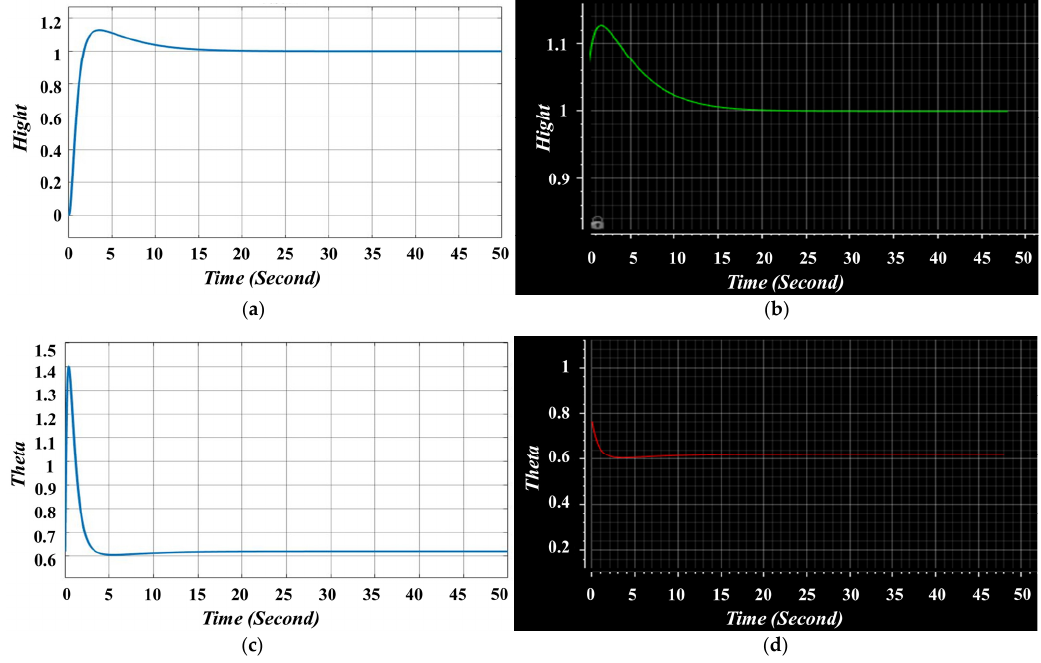
Figure 21. Simulation results of the flight control law: ( a ) the height result by Simulink; ( b ) the height result by semi-physical simulation; ( c ) the pitch angle result by Simulink; and ( d ) the pitch angle result by semi-physical simulation.